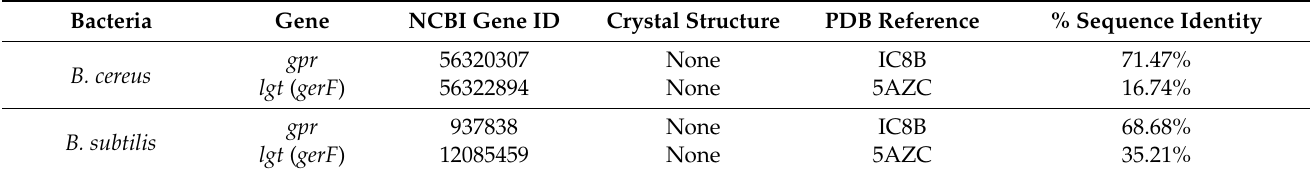
Table 6. Genes and protein information of conserved germination genes of B. cereus and B. subtilis .